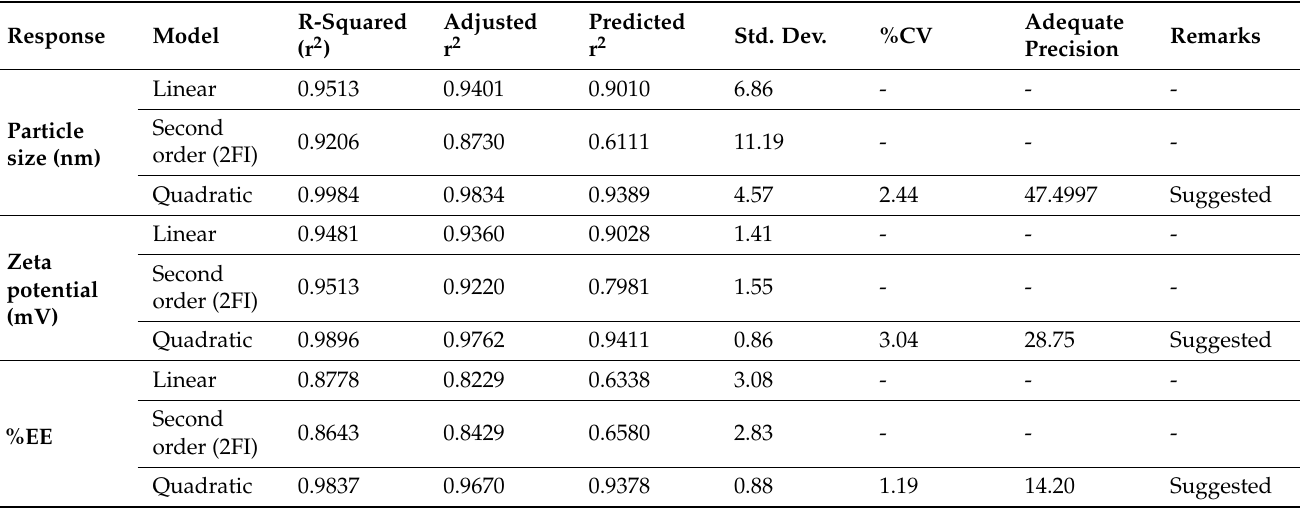
Table 3. Best-fitted model for all three dependent responses (particle size, zeta potential, and entrapment efficiency of CUR/LCSNPs).